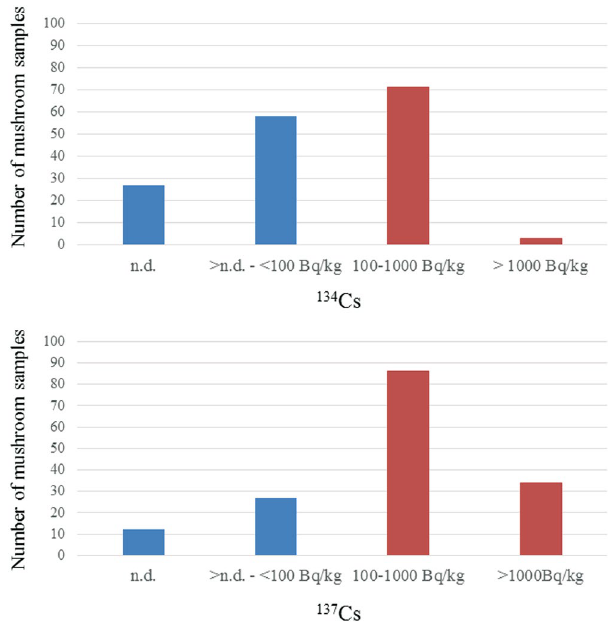
Figure 2. Distribution of concentrations of radiocesium in all samples collected in